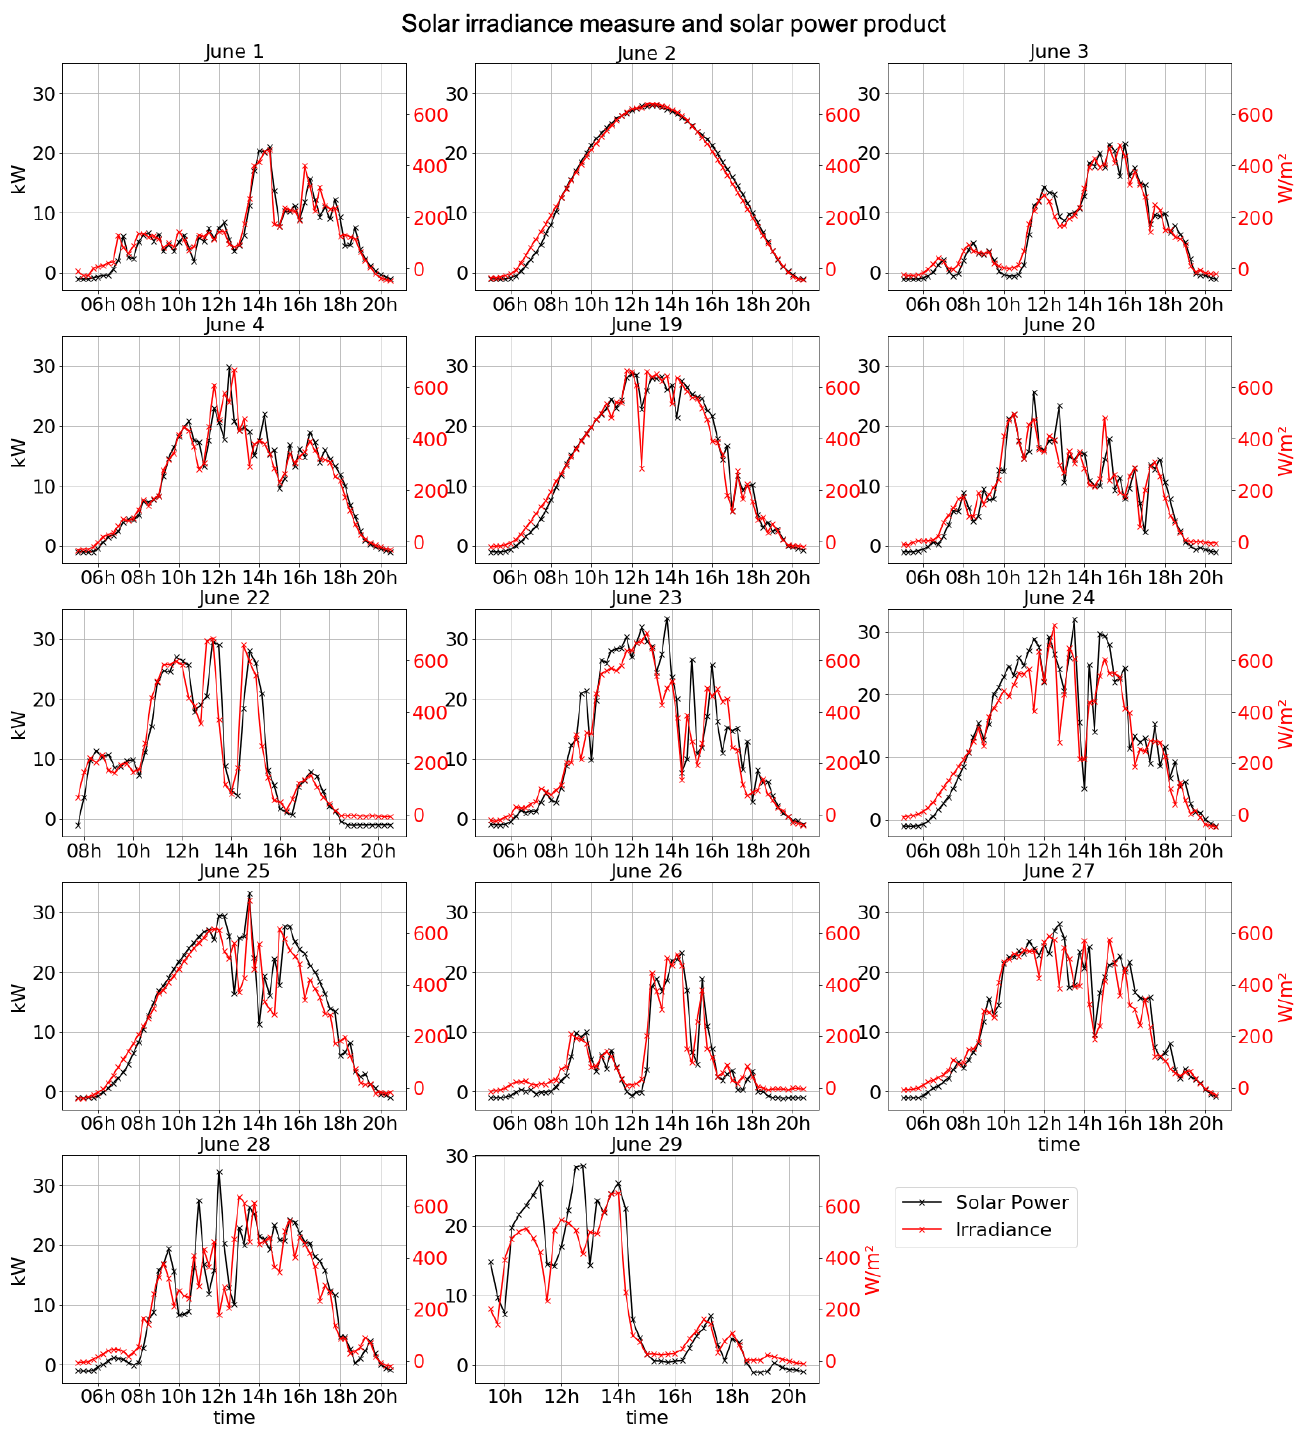
Figure A10. Solar irradiance measure from the Argonne meteorological sensor tower and solar power product from the Argonne Energy Plaza for 14 days. The two locations are 1380 m apart in a straight line